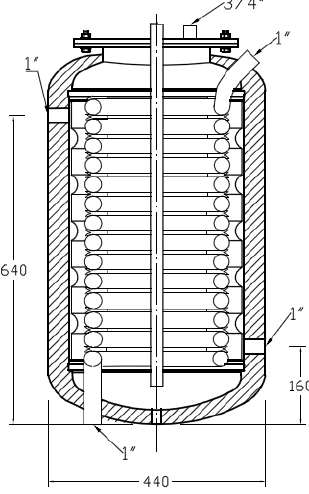
Figure 4. Diagram of the test tank (dimensions are in mm).